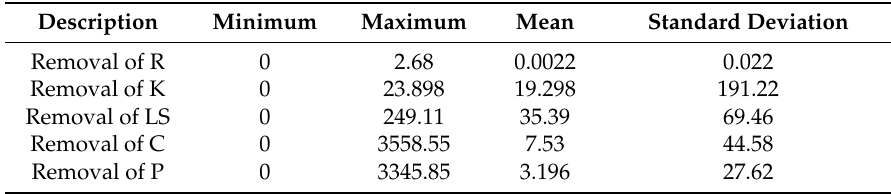
Table 4. Sensitivity analysis of factors used in RUSLE